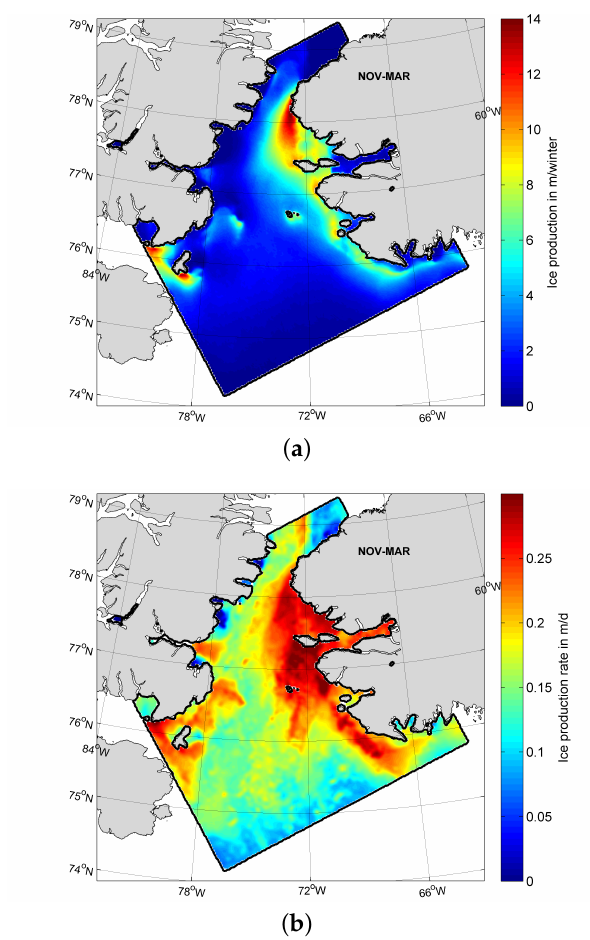
Figure 9. Spatial distribution of ( a ) the average accumulated ice production (IP, in m ¨ winter ´ 1 ) rate, as well as ( b ) the maximum daily ice production rate (in m ¨ d ´ 1 ) in the North Water Polynya for winter seasons (November to March) 2002/2003 to